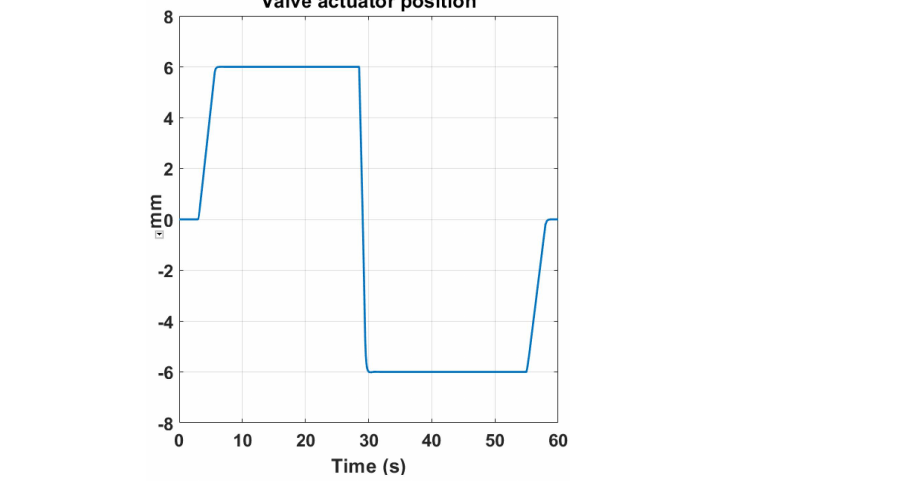
Figure 10. Variation versus time of the pneumatic muscle axial contraction.